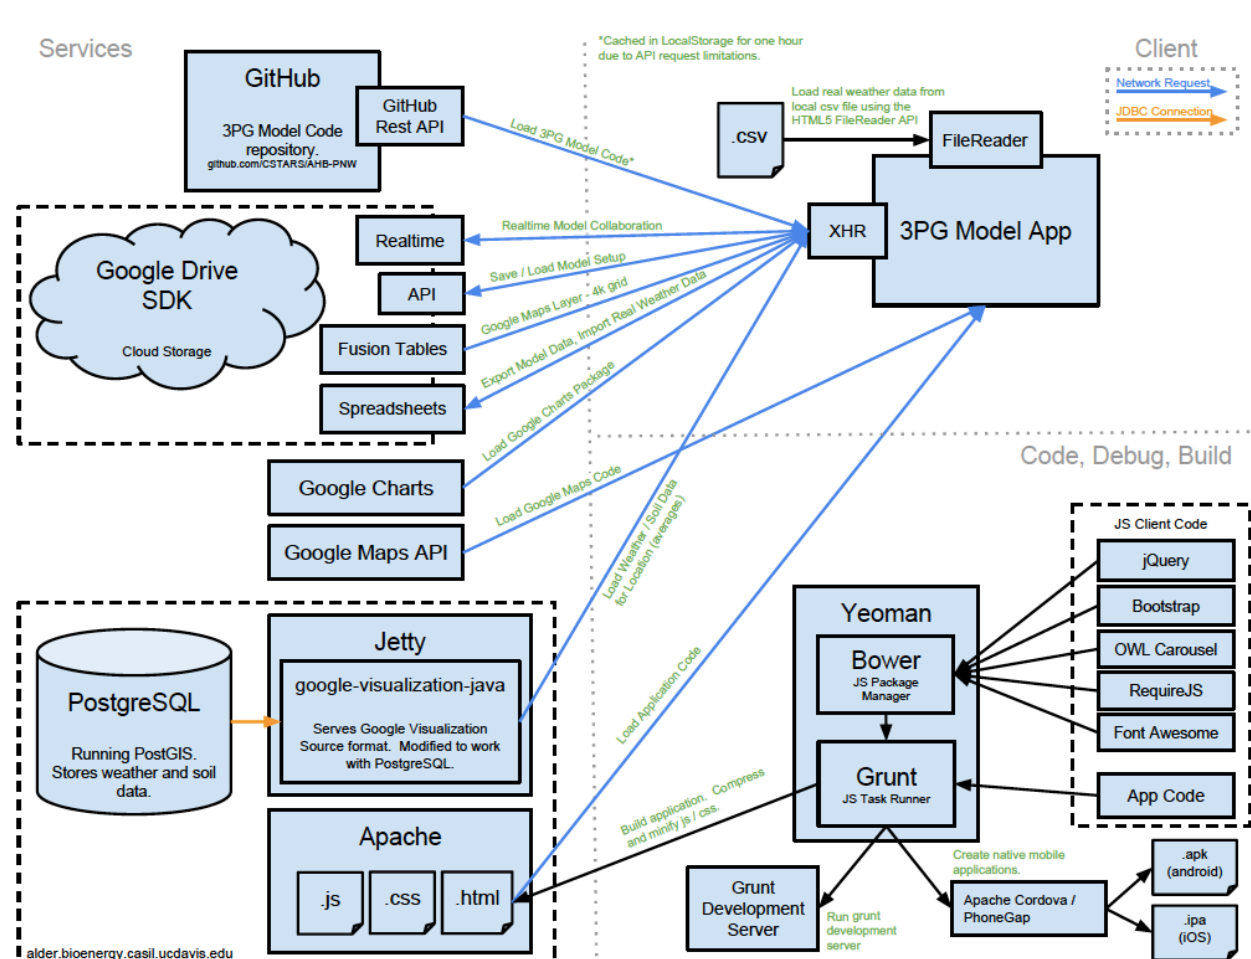
Figure 5. Technology level